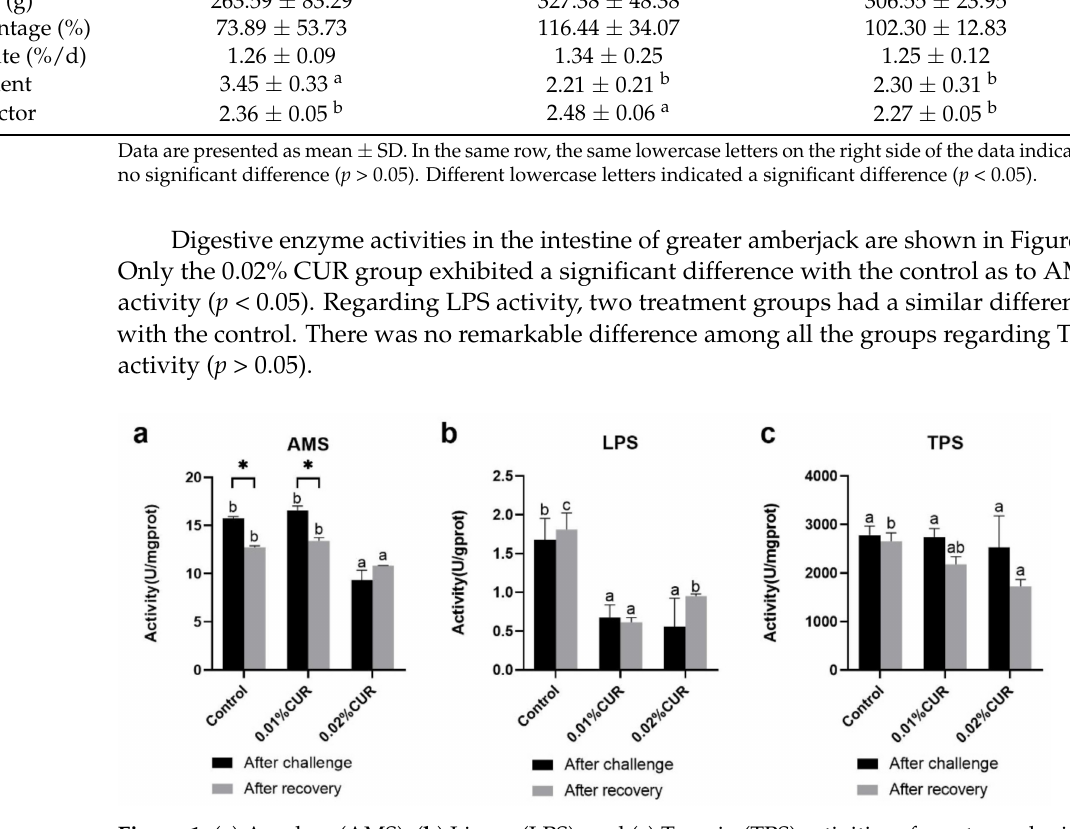
Figure 1. ( a ) Amylase (AMS), ( b ) Lipase (LPS), and ( c ) Trypsin (TPS) activities of greater amberjack fed with dietary curcumin supplementation. (Different letters above bars and asterisk sign (*) indicate significant differences at the 0.05